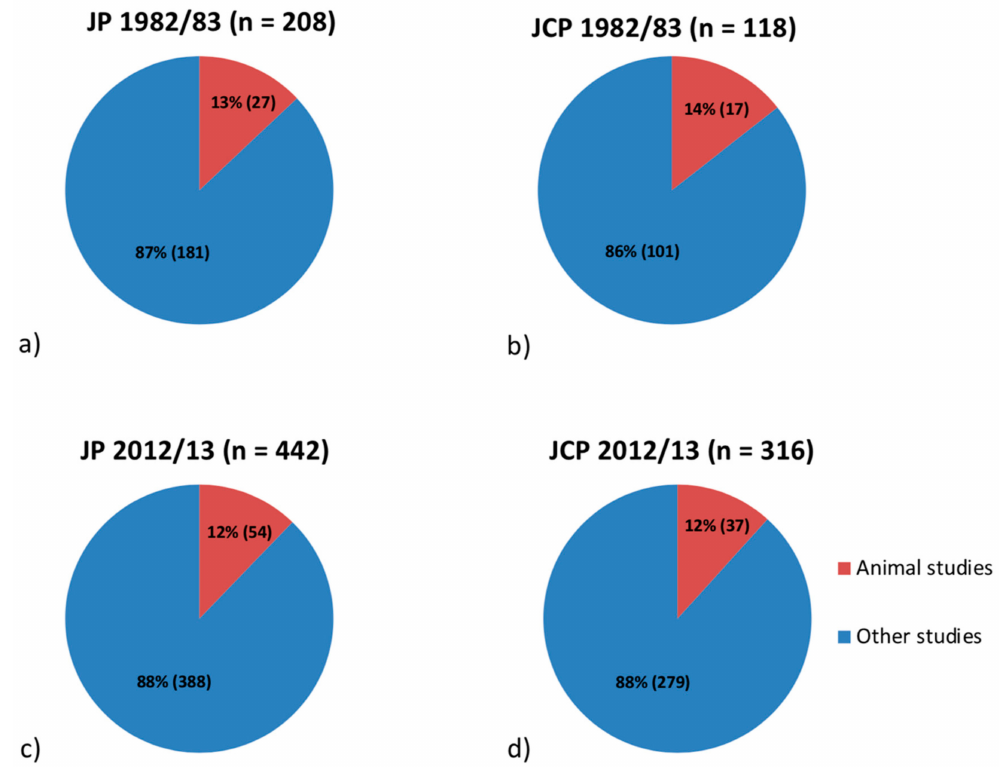
Figure 1. Proportion of articles with examinations on animals in the Journal of Periodontology (JP) ( a ) and the Journal of Clinical Periodontology (JCP) ( b ) in 1982 / 83, and in JP ( c ) and JCP ( d ) in 2012 / 13. Some articles were classified in more than one category, leading to discrepancies between the number of articles published, as is shown in the